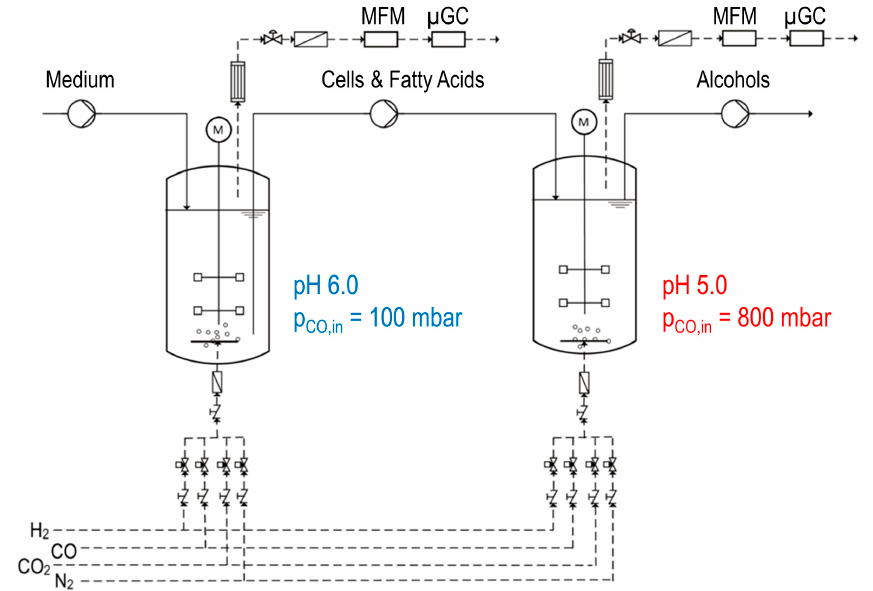
Figure 1. Scheme of the continuously operated stirred-tank reactors in series with continuous gas supply and exhaust gas analysis (mass flow meter (MFM), micro-gas chromatograph ( µ GC)) adapted with permission from Doll et al. [20]. 2018, Kathrin Doll.